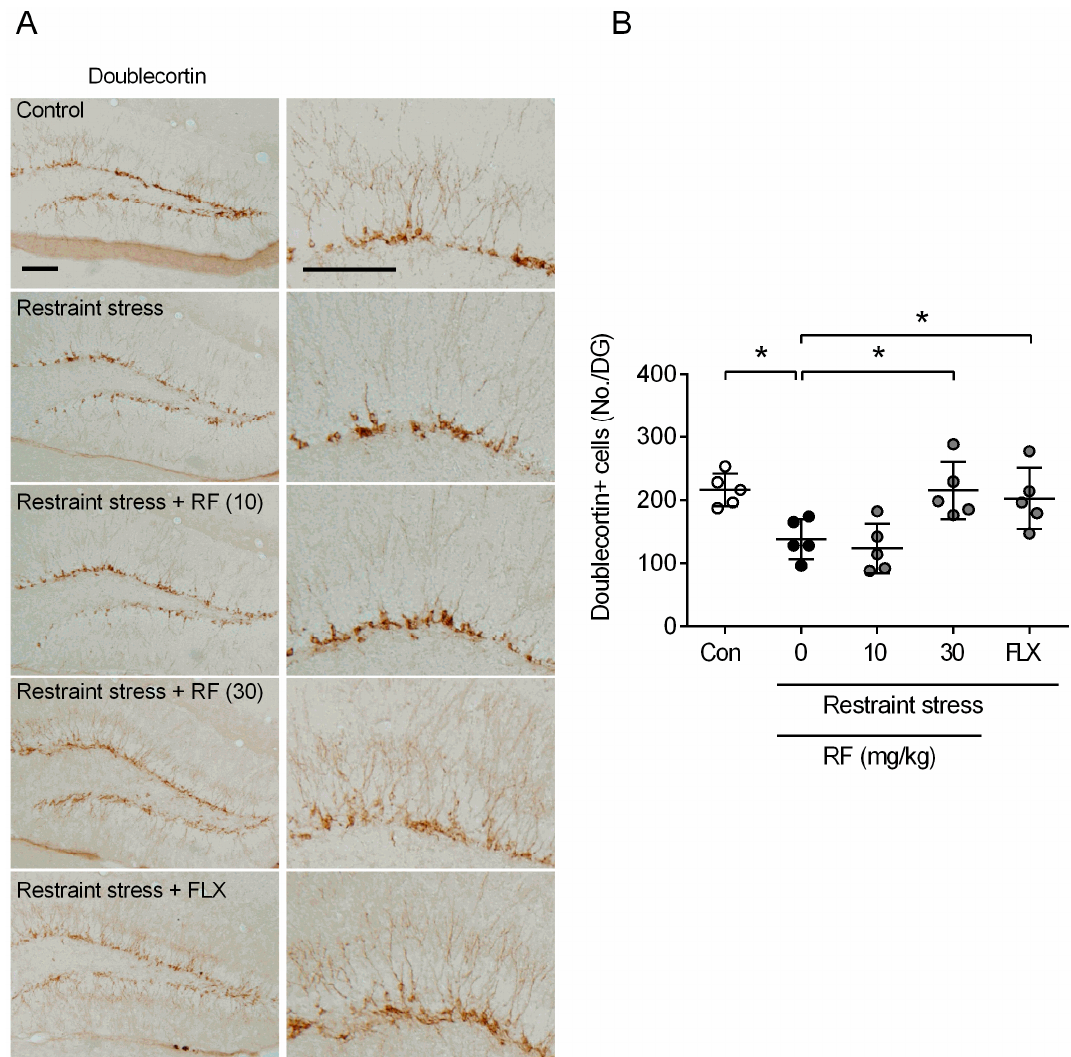
Figure 3. Effect of rubrofusarin on adult neurogenesis: ( A ) Photomicroscopic image of doublecortin-positive cells in the dentate gyrus region. Bar = 100 µ m. ( B ) Quantitative analysis of the number of doublecortin-positive cells in the dentate gyrus region. Data represented as mean ± SD with raw data. * p < 0.05.